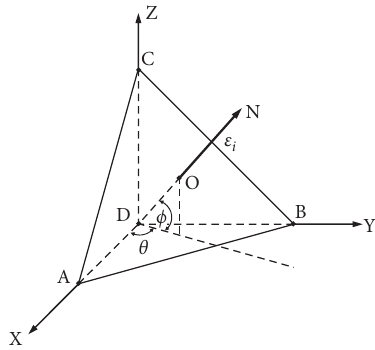
Figure 8: Principal strain ε i and its direction ON at critical point D